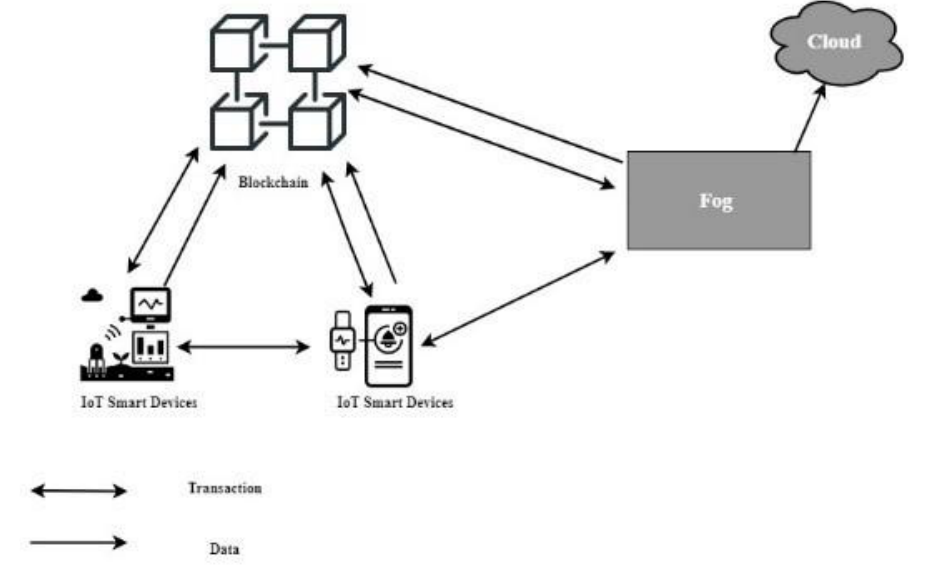
Figure 18. BIoT based hybrid